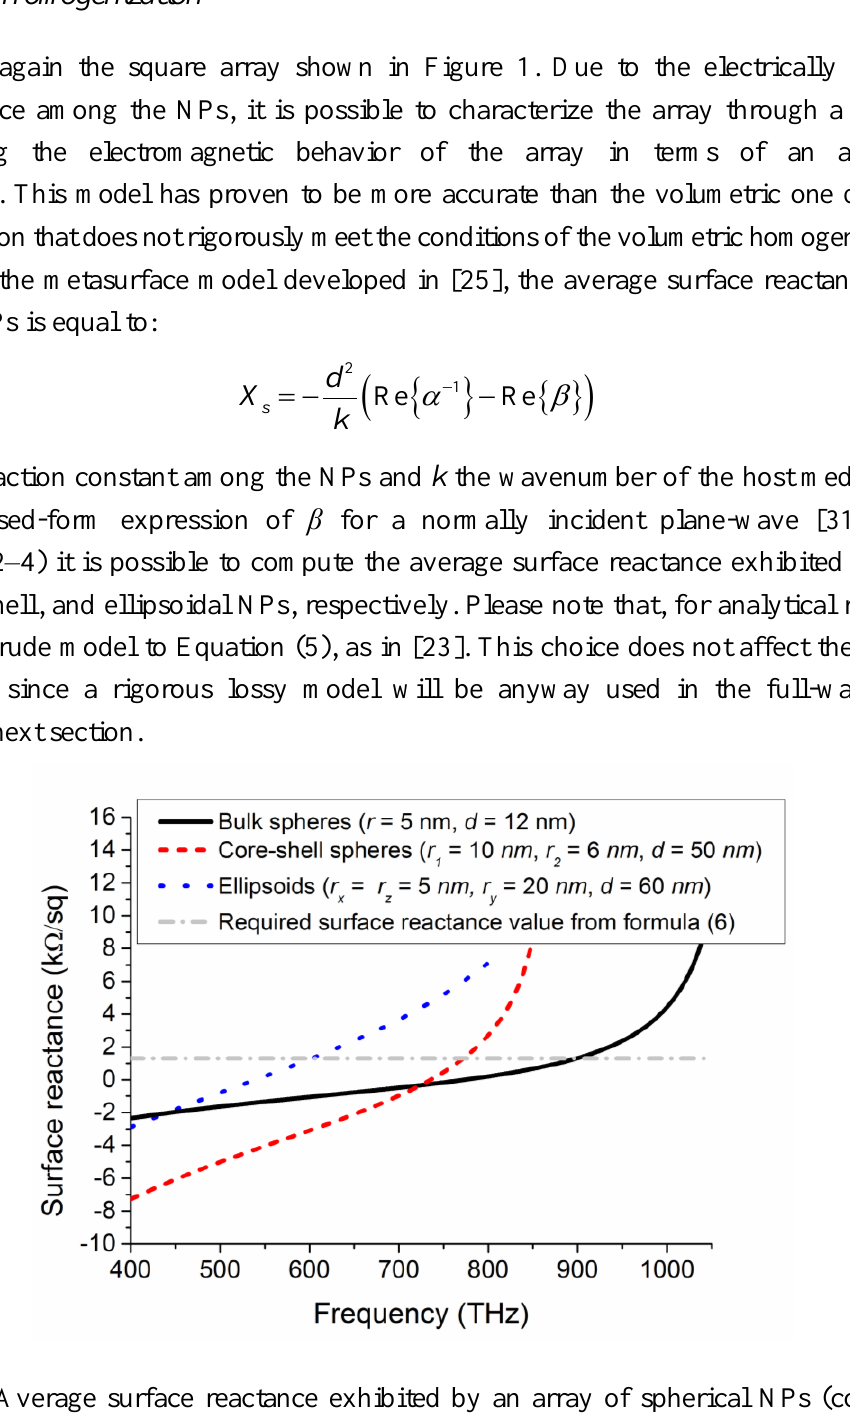
Figure 4. Average surface reactance exhibited by an array of spherical NPs (continuous line), core-shell NPs (dashed line), and ellipsoidal NPs (dash-dotted